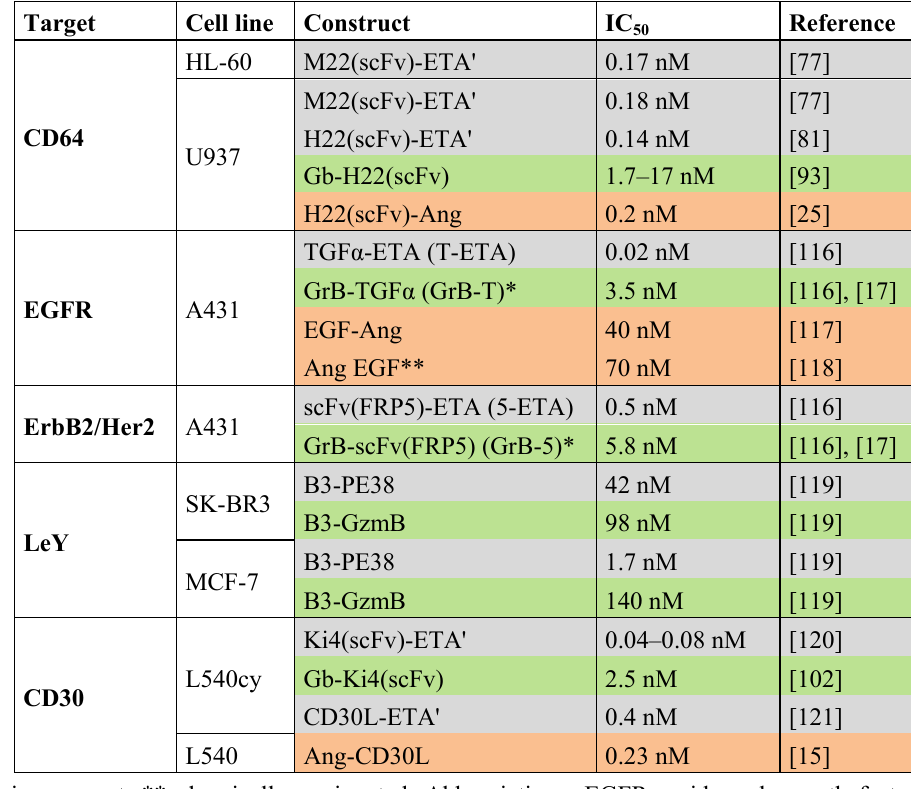
Table 1. Comparison of immunotoxins (ITs), based on truncated ETA, and human cytolytic fusion proteins (hCFPs), based on granzyme B or